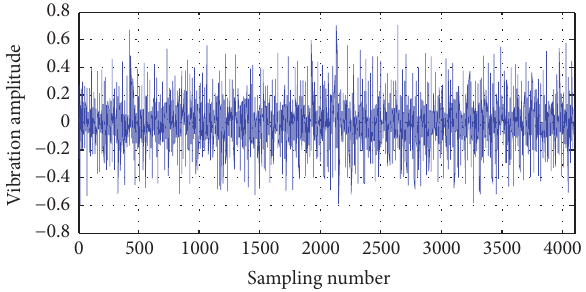
Figure 4: Test bed.